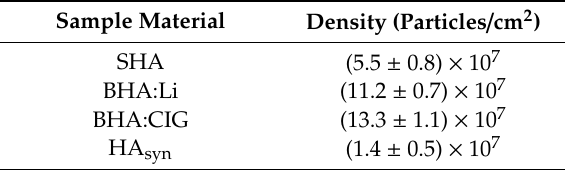
Table 7. Droplets density in the case of synthetic HA and di ff erent BioHA coatings synthesized by PLD, using the same experimental